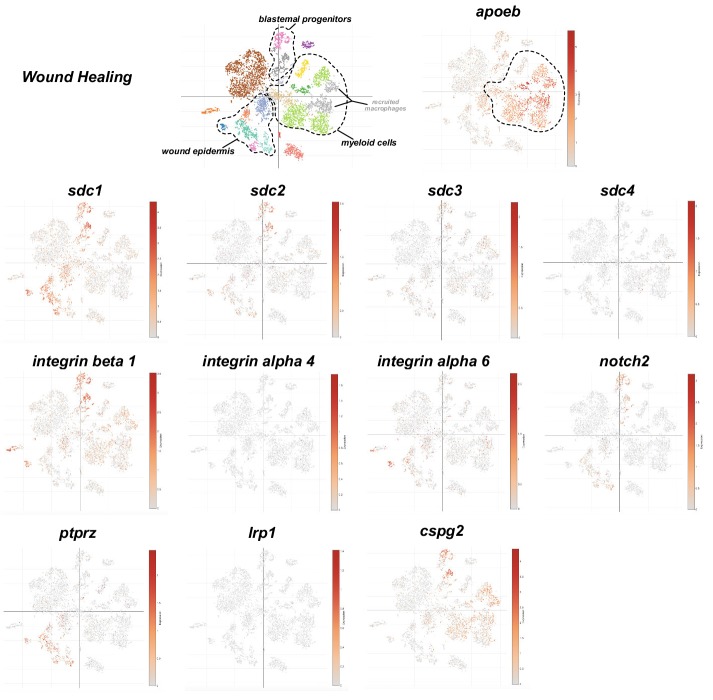
Mk receptors are not highly expressed in myeloid cells during wound healing.Publicly available single cell expression data of mk receptors from Leigh et al. (2018). Top left panel shows original clustering of single cell expression profiles at the wound healing stage of blastemal progenitors, wound epidermis, and myeloid cell populations circled. Top right panel shows t-SNE plot of apoeb expression, which was identified as highly enriched in myeloid cells, to give an example of a highly expressed gene in the myeloid cell populations. All panels below are t-SNE plots showing expression of mk receptors.